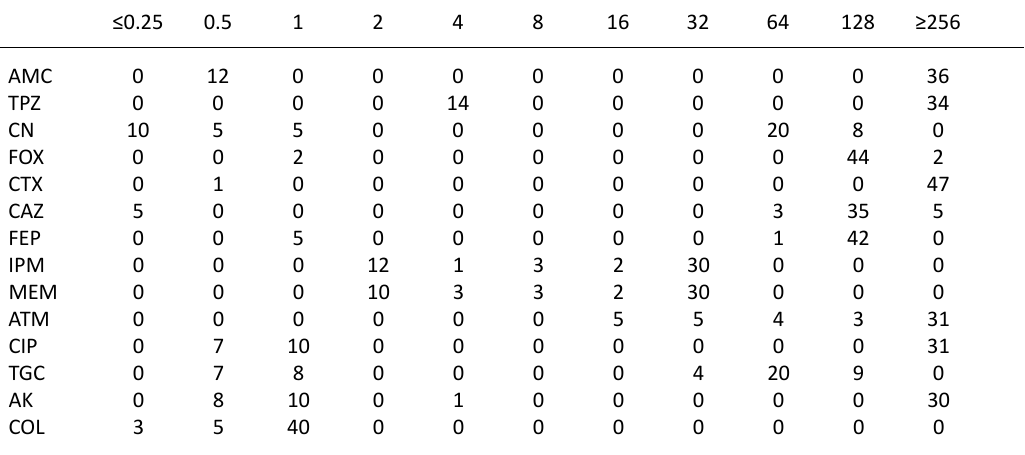
Table 2. Minimum inhibitory concentration (MIC) distributions of antimicrobial agents for 48 isolates of A. baumannii